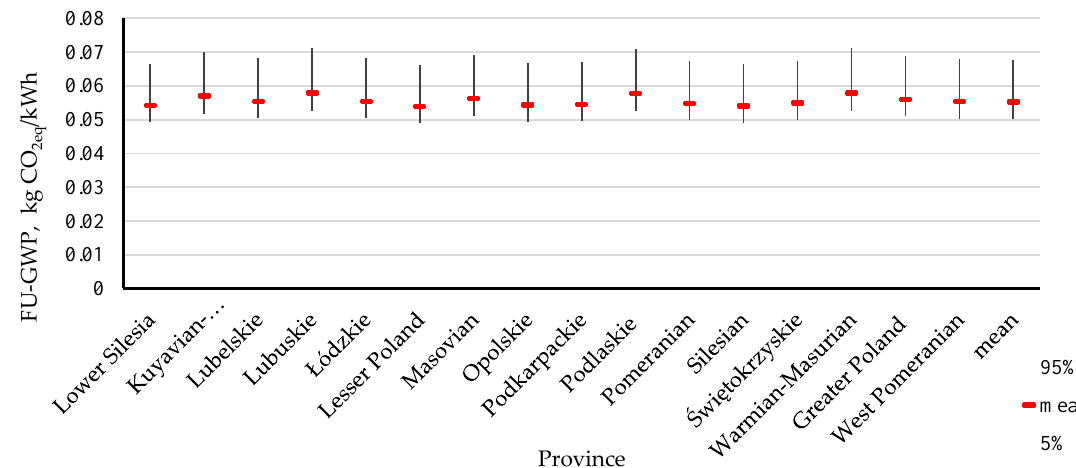
Figure 8. Monte Carlo results of FU-GWP calculated for the provinces with a confidence interval of 90%. As can be inferred, FU-GWP differs between provinces, first on the basis of various productivity of PV installation and then transport distances. The correlation between yearly electricity productivity can be observed on the base of Table 1 since the provinces such as Lower Silesia, Opolskie, Silesian, characterised by the highest productivity represent the lowest FU-GWP indicators. The outcomes of calculations are comparable to previous studies on PV systems working in temperate climate conditions [67–69], and smaller FU-GWP indicators result from the higher efficiencies of the analysed PV panels. At the same time, the calculated emission rate is similar to the literature results of the carbon emission rate for PV installations working under similar solar irradiation (1222 kWh/m 2 /year, Germany), equal to 55 g CO 2eq /kWh [70]. Calculation of avoided emission ΔGHG, Mg CO 2eq , was based on unit GWP indica- tors obtained for hard coal (0.966 kg CO 2eq /kWh), lignite (1.164 kg CO 2eq /kWh), natural gas (0.738 kg CO 2eq /kWh), and Polish energy mix called MIX PL (0.804 kg CO 2eq /kWh) com- pared with the data in Table 4 [21,64,71]. Table 4. ΔGHG, Mg CO 2eq, calculated for provinces in Poland in 30 years perspective on the basis of individual GWP differences for the energy sources considered to be replaced, kg CO 2eq /kWh. Province